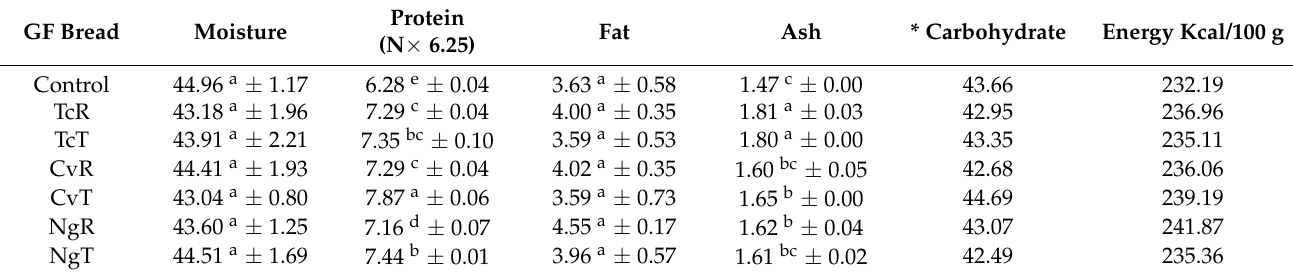
Table 4. Major chemical composition (g/100 g) and gross energy value of the control and microalgae biomass-enriched gluten-free breads. Tetraselmis chuii (TcR), Tetraselmis chuii ethanol-treated (TcT), Chlorella vulgaris (CvR), Chlorella vulgaris ethanol-treated (CvT), Nannochloropsis gaditana (NgR), and Nannochloropsis gaditana ethanol-treated